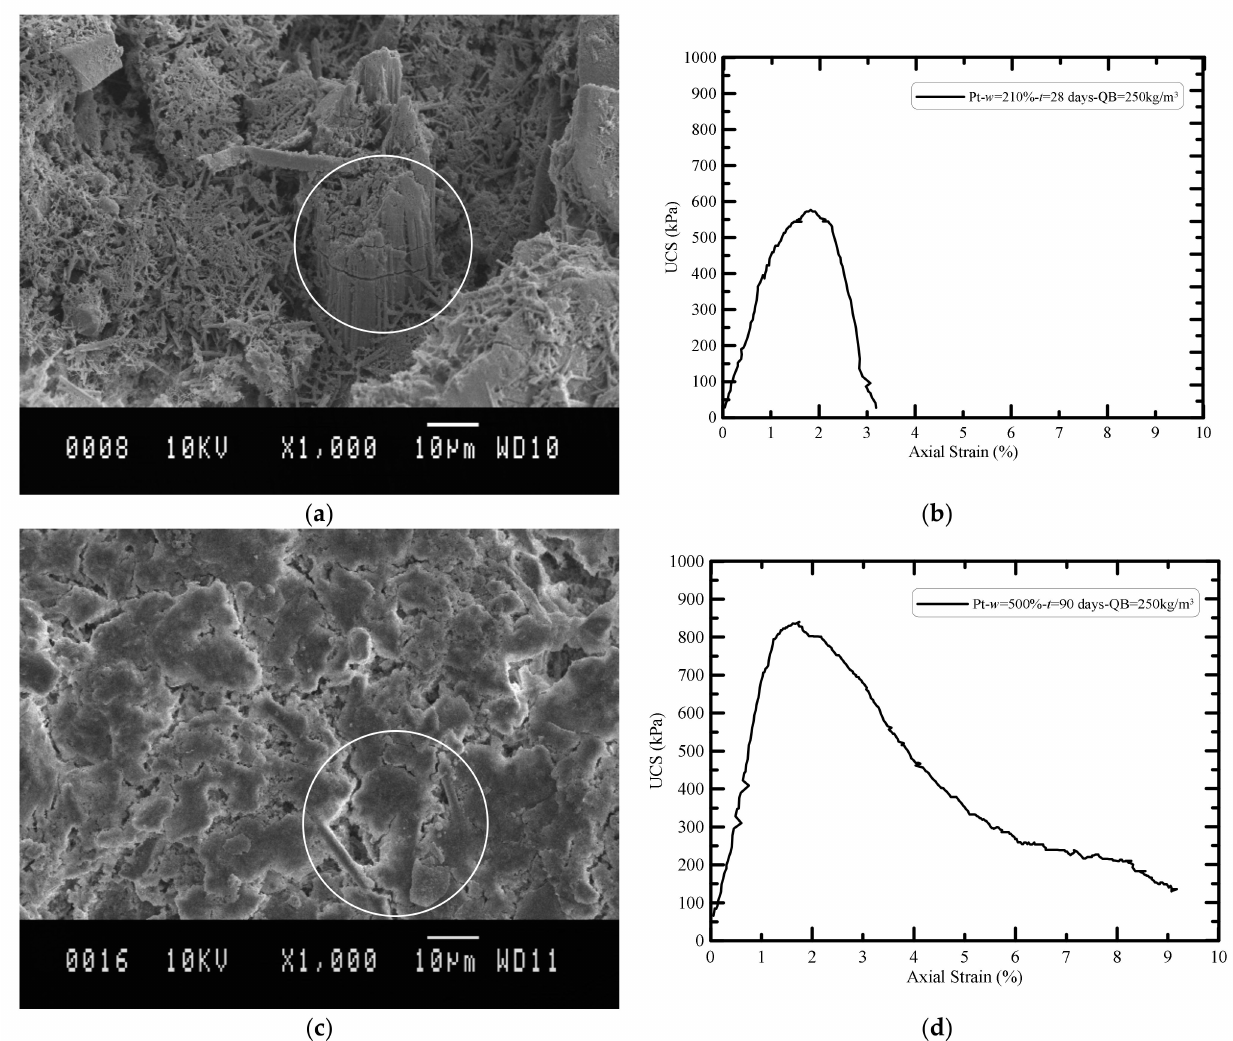
Figure 18. SEM image of Pt-PC mix with its corresponding UCS tests results; ( a , b ) after 28 days of curing and ( c , d ) after 90 days of